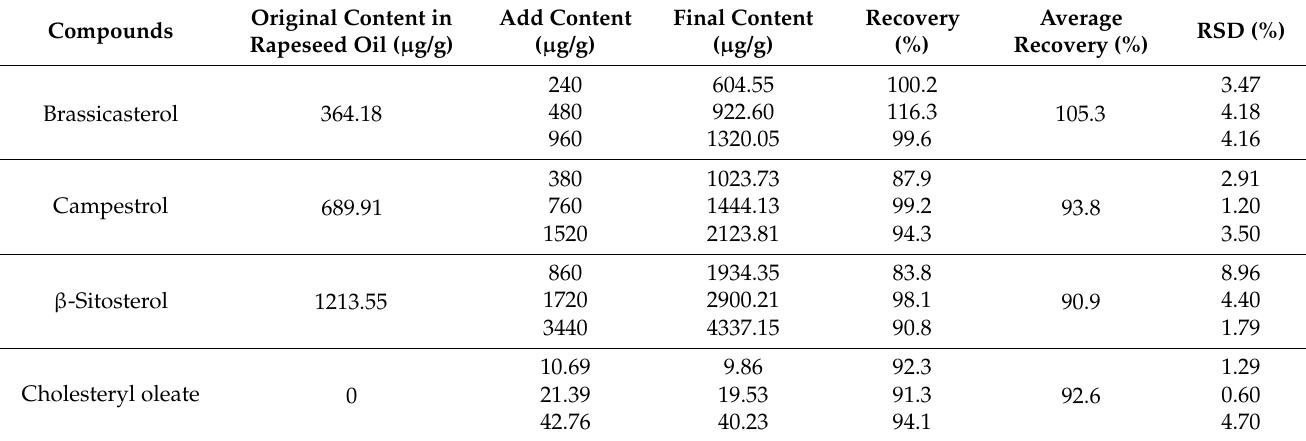
Table 2. Recovery of phytosterols in rapeseed